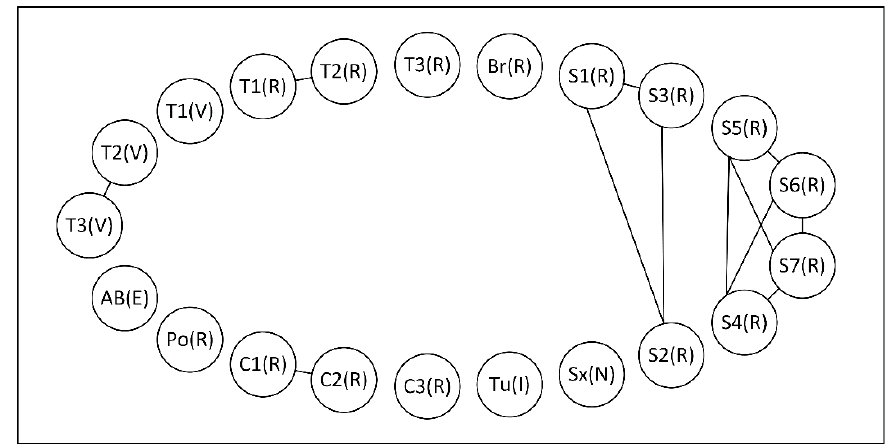
Figure 4. Asset level model.